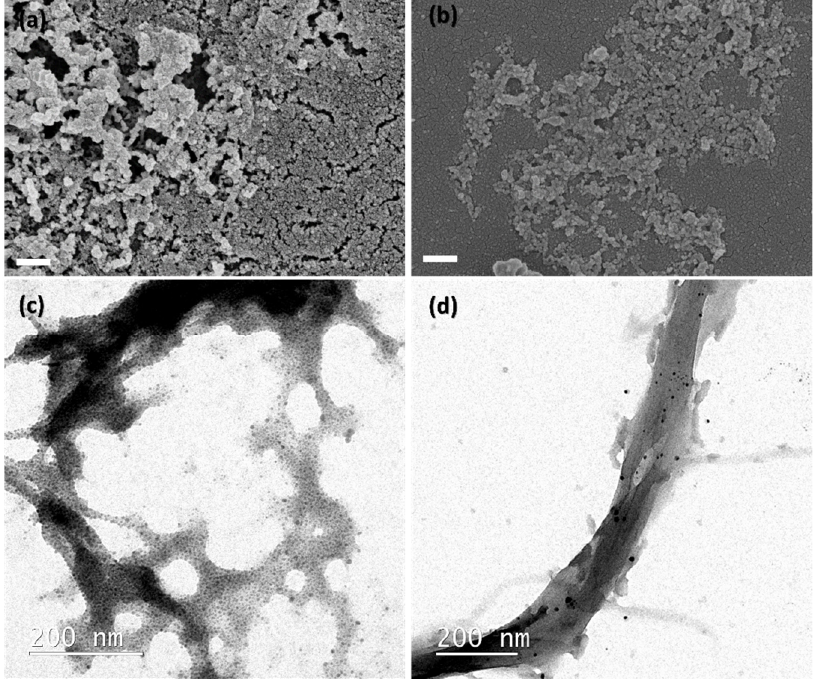
Figure 4. SEM and TEM images from ( a ) Ag NP/CNC-TEMPO 3, ( b ) Ag NP/CNFc 2, ( c ) Ag NP/CNC-TEMPO 1 and ( d ) Ag NP/CNFc 3. Scale bars from SEM images are 300 nm. NP/CNC-TEMPO 1 and ( d ) Ag NP/CNFc 3. Scale bars from SEM images are 300